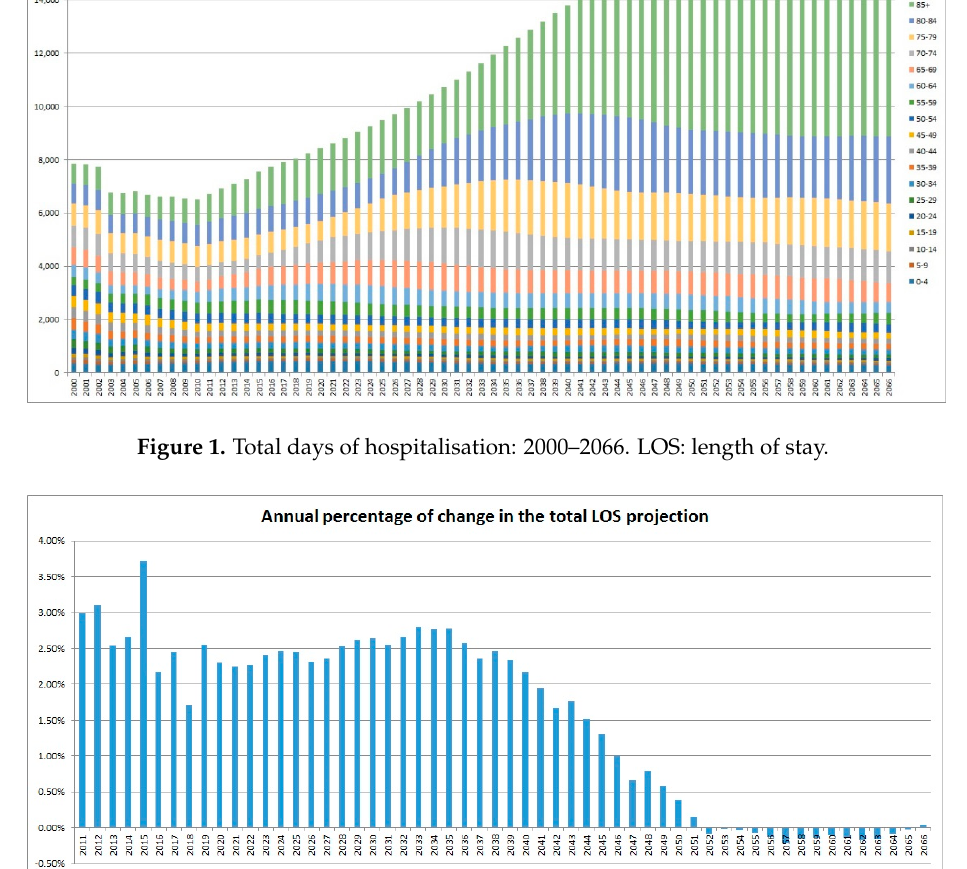
Figure 2. Annual % of changes in the TLOS: 2011–2066. TLOS: the total length of stay.